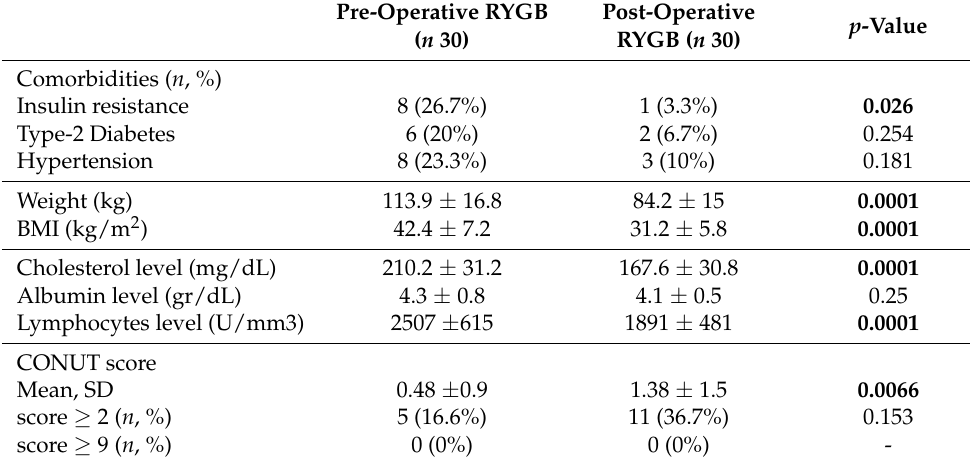
Table 5. Pre- vs. post-operative data for RYGB.